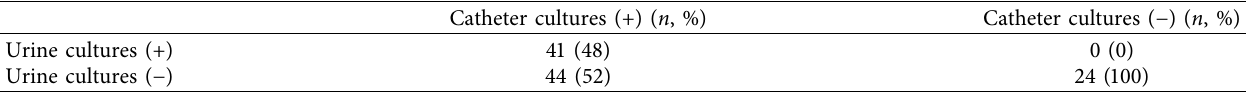
Table 4: Comparison of the results of urine cultures and catheter